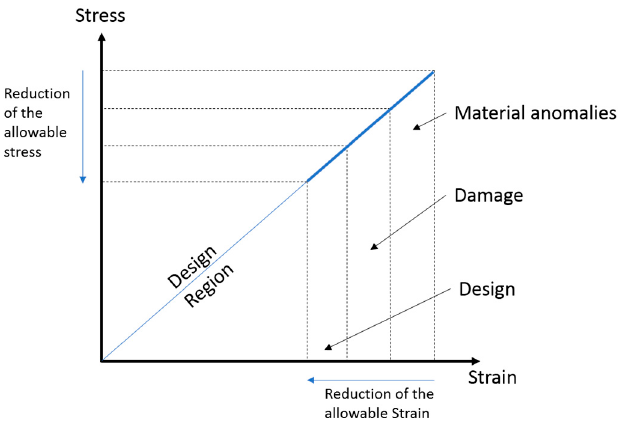
Figure 33. Schematic representation of scattering factors constraining the composite design.